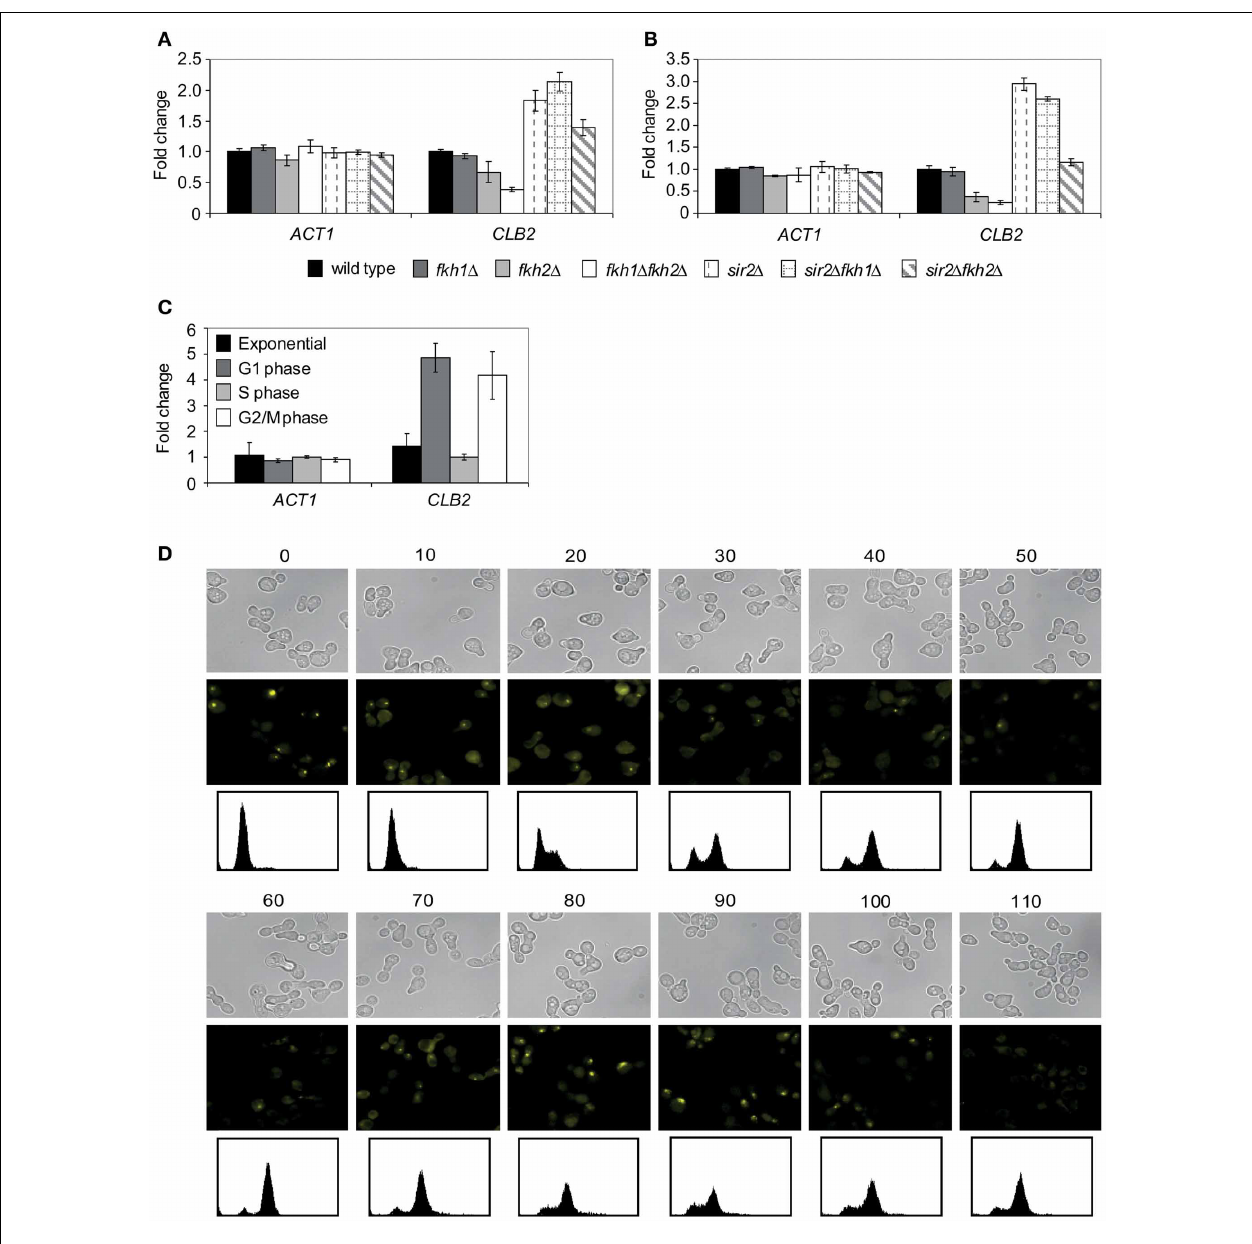
FIGURE 3 | Sir2 regulates the CLB2 transcript level and binds to the CLB2 promoter in a cell cycle-dependent manner. (A,B) Quantitative Real-Time PCR. Total RNA was isolated from (A) hydroxyurea- or (B) nocodazole- arrested wild type, fkh1 (cid:2) , fkh2 (cid:2) , fkh1 (cid:2) fkh2 (cid:2) , sir2 (cid:2) , fkh1 (cid:2) sir2 (cid:2) , and fkh2 (cid:2) sir2 (cid:2) cells. The ACT1 gene was used as control. Each bar represents the mean average obtained from three independent experiments. (C) ChIP assay. Protein/DNA complexes were precipitated from cells grown in exponential phase or synchronized with α -factor (G1 phase), hydroxyurea (S phase) or nocodazole (M phase)